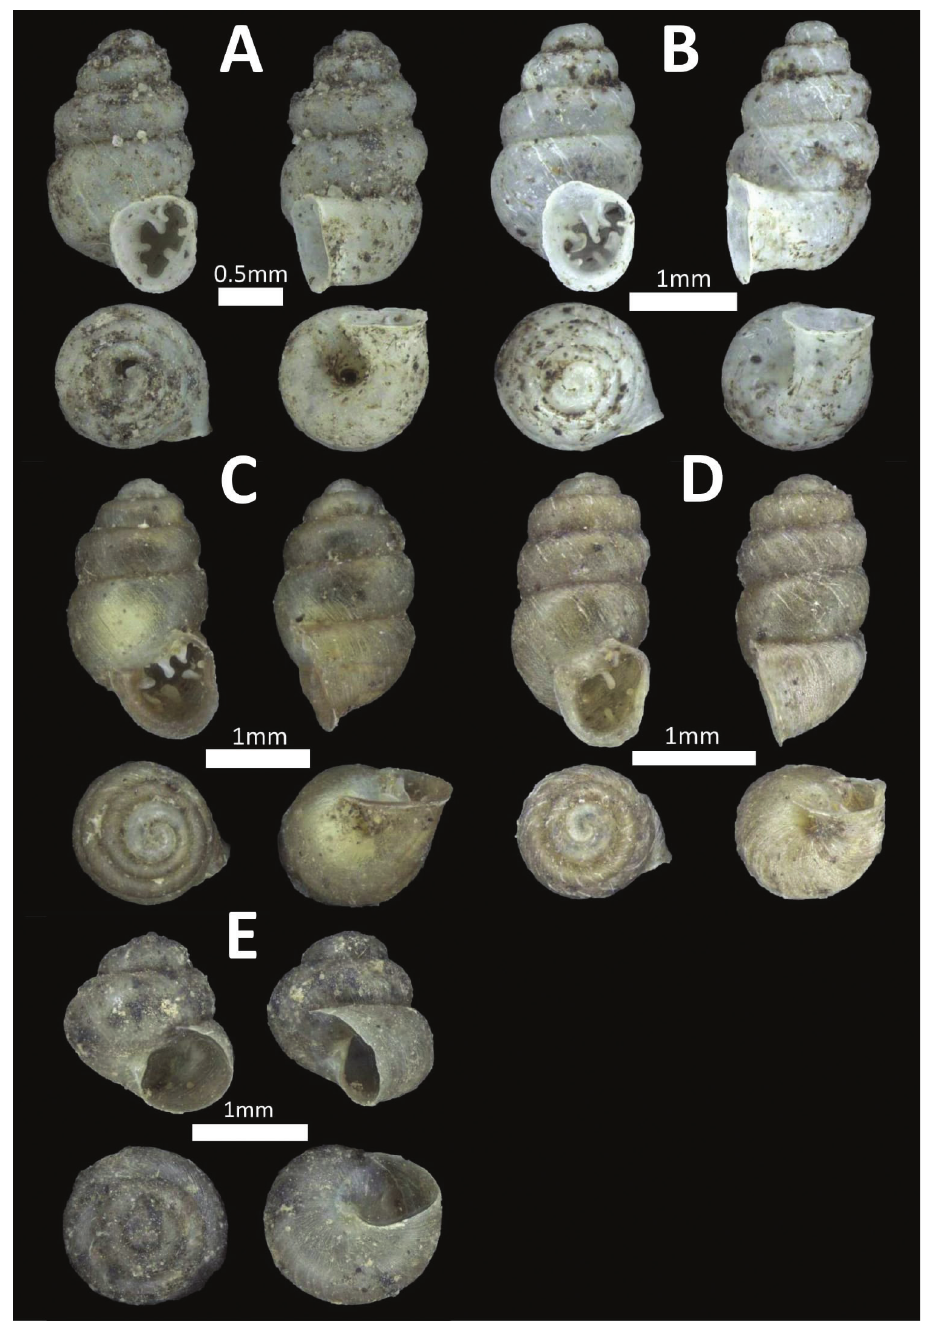
Figure 22. Family Vertiginidae. A Gastrocopta avanica (BOR/MOL 10376) B Gastrocopta recondita (BOR/MOL 8914) C Nesopupa moreleti (BOR/MOL 7182) D Nesopupa malayana (BOR/MOL 12324) E Ptychopatula orcula (BOR/MOL